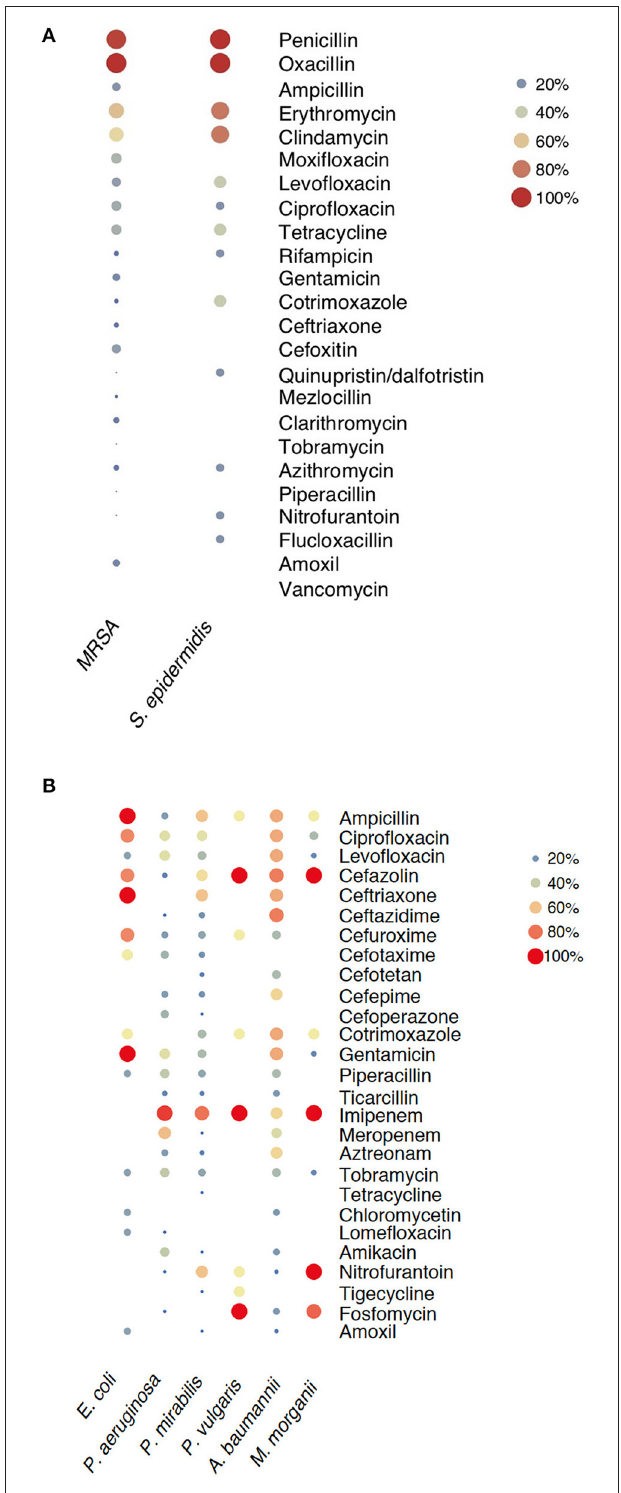
FIGURE 5 | Drug resistance patterns of MDR bacteria. (A) Drug resistance patterns of MDR Gram-positive bacteria. (B) Drug resistance patterns of MDR Gram-negative bacteria. The color and size of the bubbles indicate the percentage of bacteria that are resistant to certain antibiotics. The blank indicates no